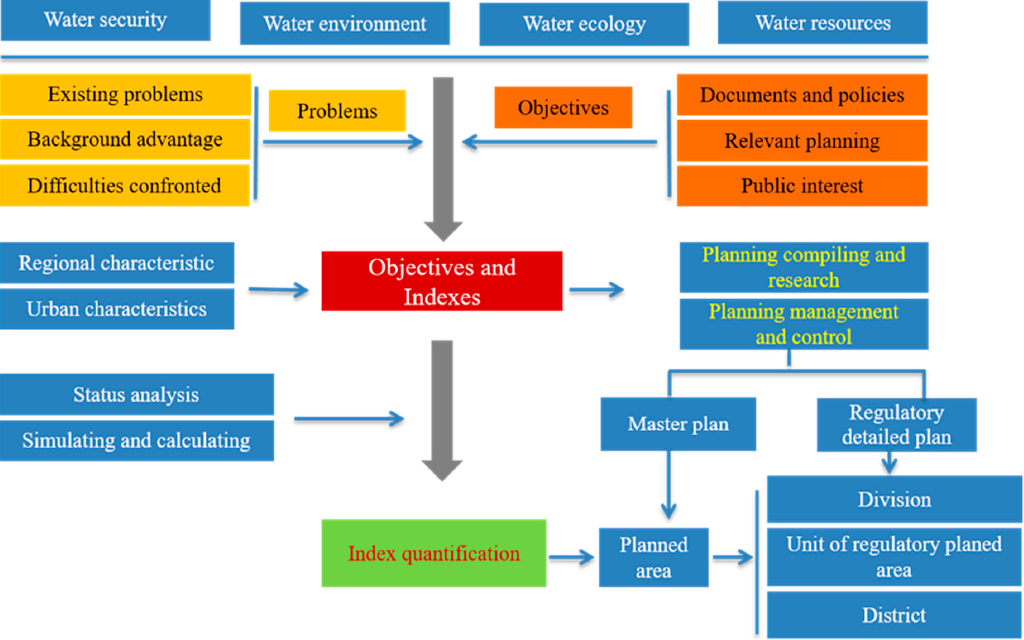
Figure 3. Technological pathways of objectives and indexes for the construction of a sponge city.